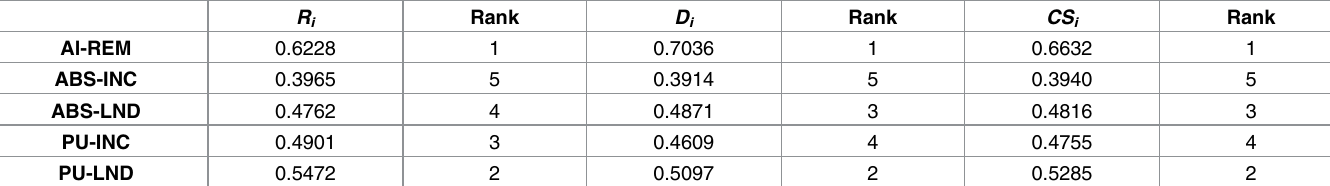
Table 8. Ranking of five material alternatives.